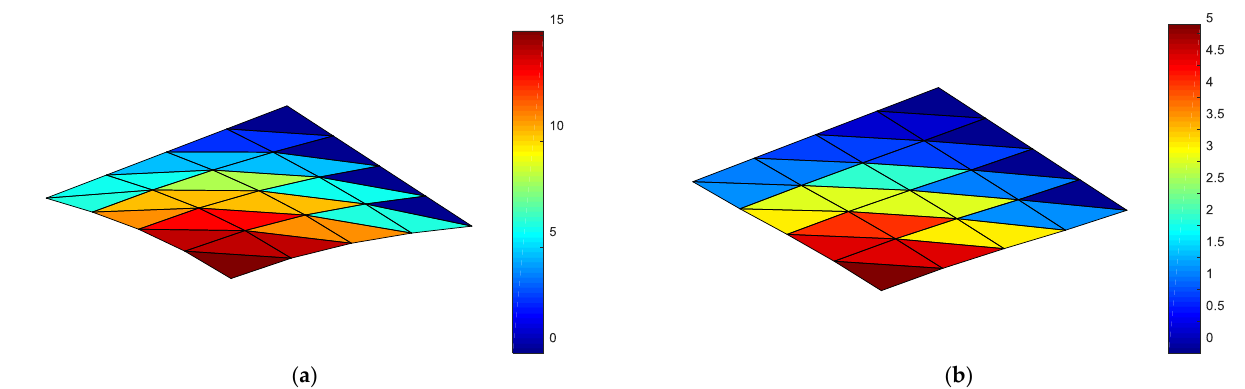
Figure 4. Mesh of one quarter of a square plate (4 × 4).